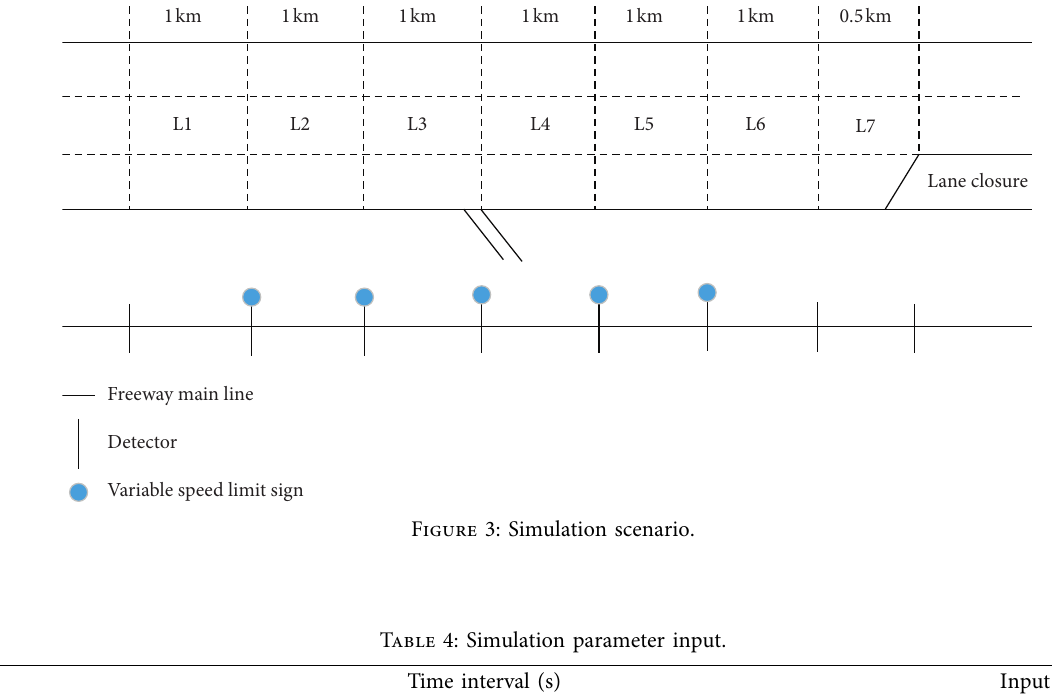
Figure 3: Simulation scenario.